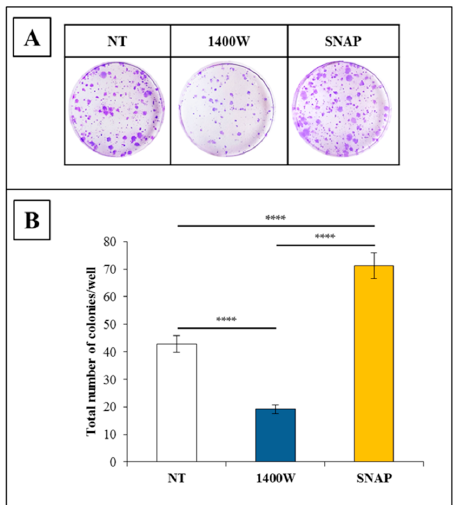
Figure 3. Nitric oxide is involved in the clonogenic potential of U-87 MG cells. ( A ) Representative microscopic images of clonogenic assay of U-87 MG cells after daily treatment for 10 days with NOS2 activity inhibitor 1400W (100 μ M) or nitric oxide(NO)-donor S-nitroso-N-acetylpenicillamine (SNAP) (100 μ M). NT = not treated. ( B ) Quantitative results of clonogenic assay expressed as total number of surviving colonies/well. Viable colonies with diameter >0.3 mm were counted with an ocular micrometer (mean ± SEM of three independent experiments in triplicate). For comparative analysis of groups of data, one-way ANOVA followed by Bonferroni post hoc test was used (**** p < 0.0001).